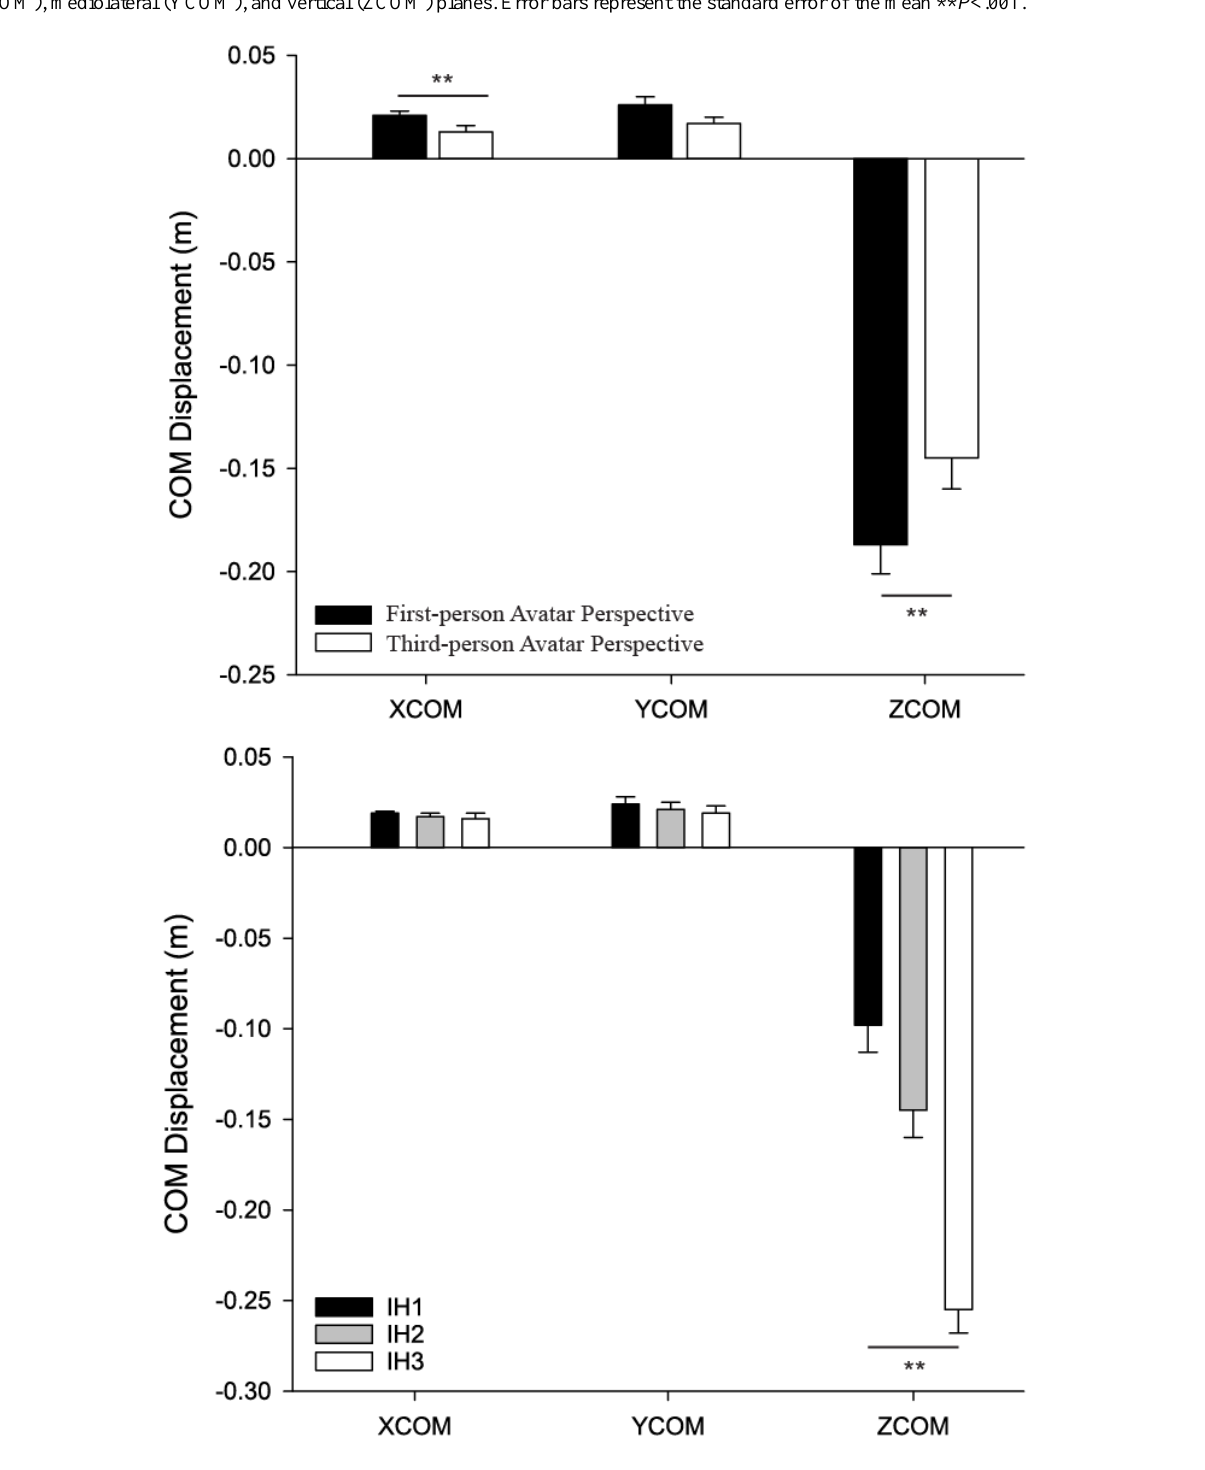
Figure 7. Effects of avatar perspective (top panel) and : predicted interception heights (bottom panel) on mean COM excursions in the antero-posterior (XCOM), mediolateral (YCOM), and vertical (ZCOM) planes. Error bars represent the standard error of the mean ** P